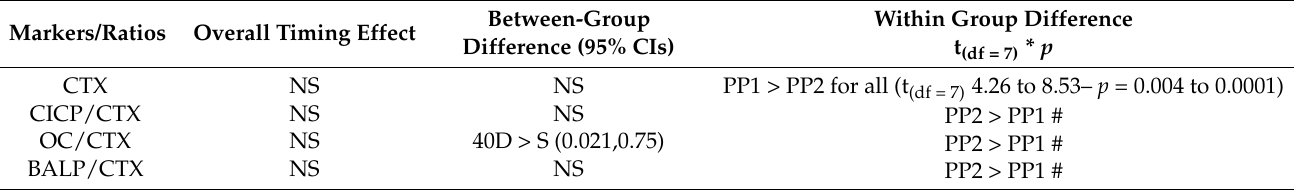
Figure 6. Comparisons between AUCs for two postprandial periods, PP1 and PP2 for CTX ( A ) and for the ratios of markers of bone formation over bone resorption ( B – D ). D=Down prandial AUC, U = Up prandial AUC, S = sedentary prandial AUC. Table 6. Between group and within-group timing differences in postprandial